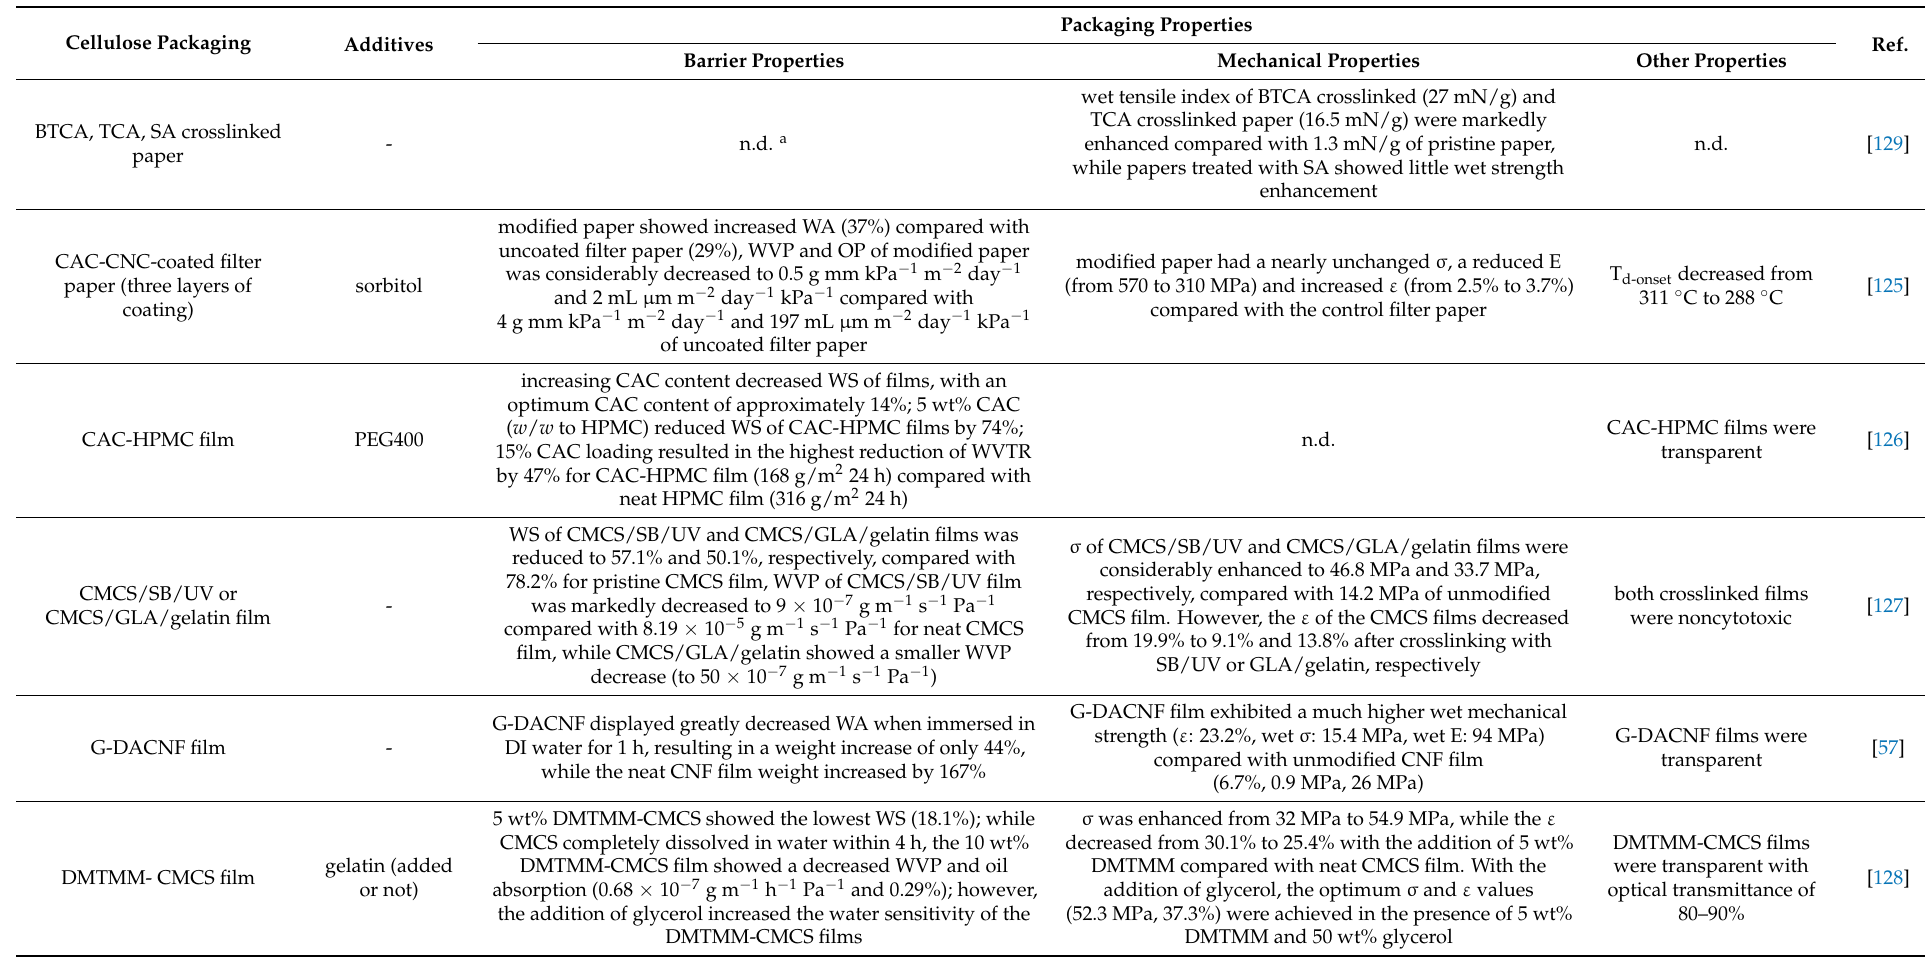
Table 9. Overview of crosslinked cellulose materials in food packaging